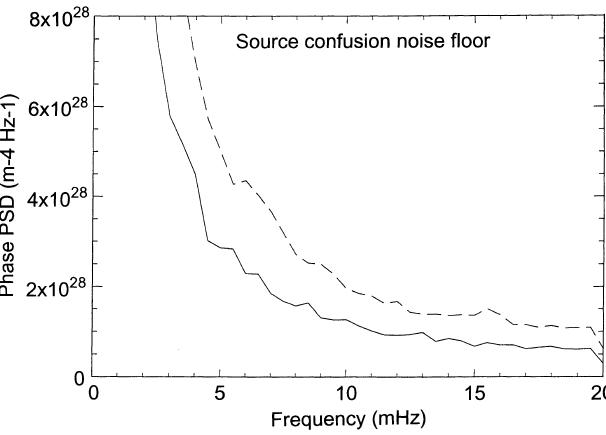
Fig. 6. Radio-frequency noise spectrum calculated from the differ- ence of two simultaneously measured frequencies, 307.5 and 333 MHz. The dashed line represents data taken during the 1991–1993 sessions (fewer antennas per array) and the solid line represents data from sessions during 1990 and 1994 (all available antennas in one